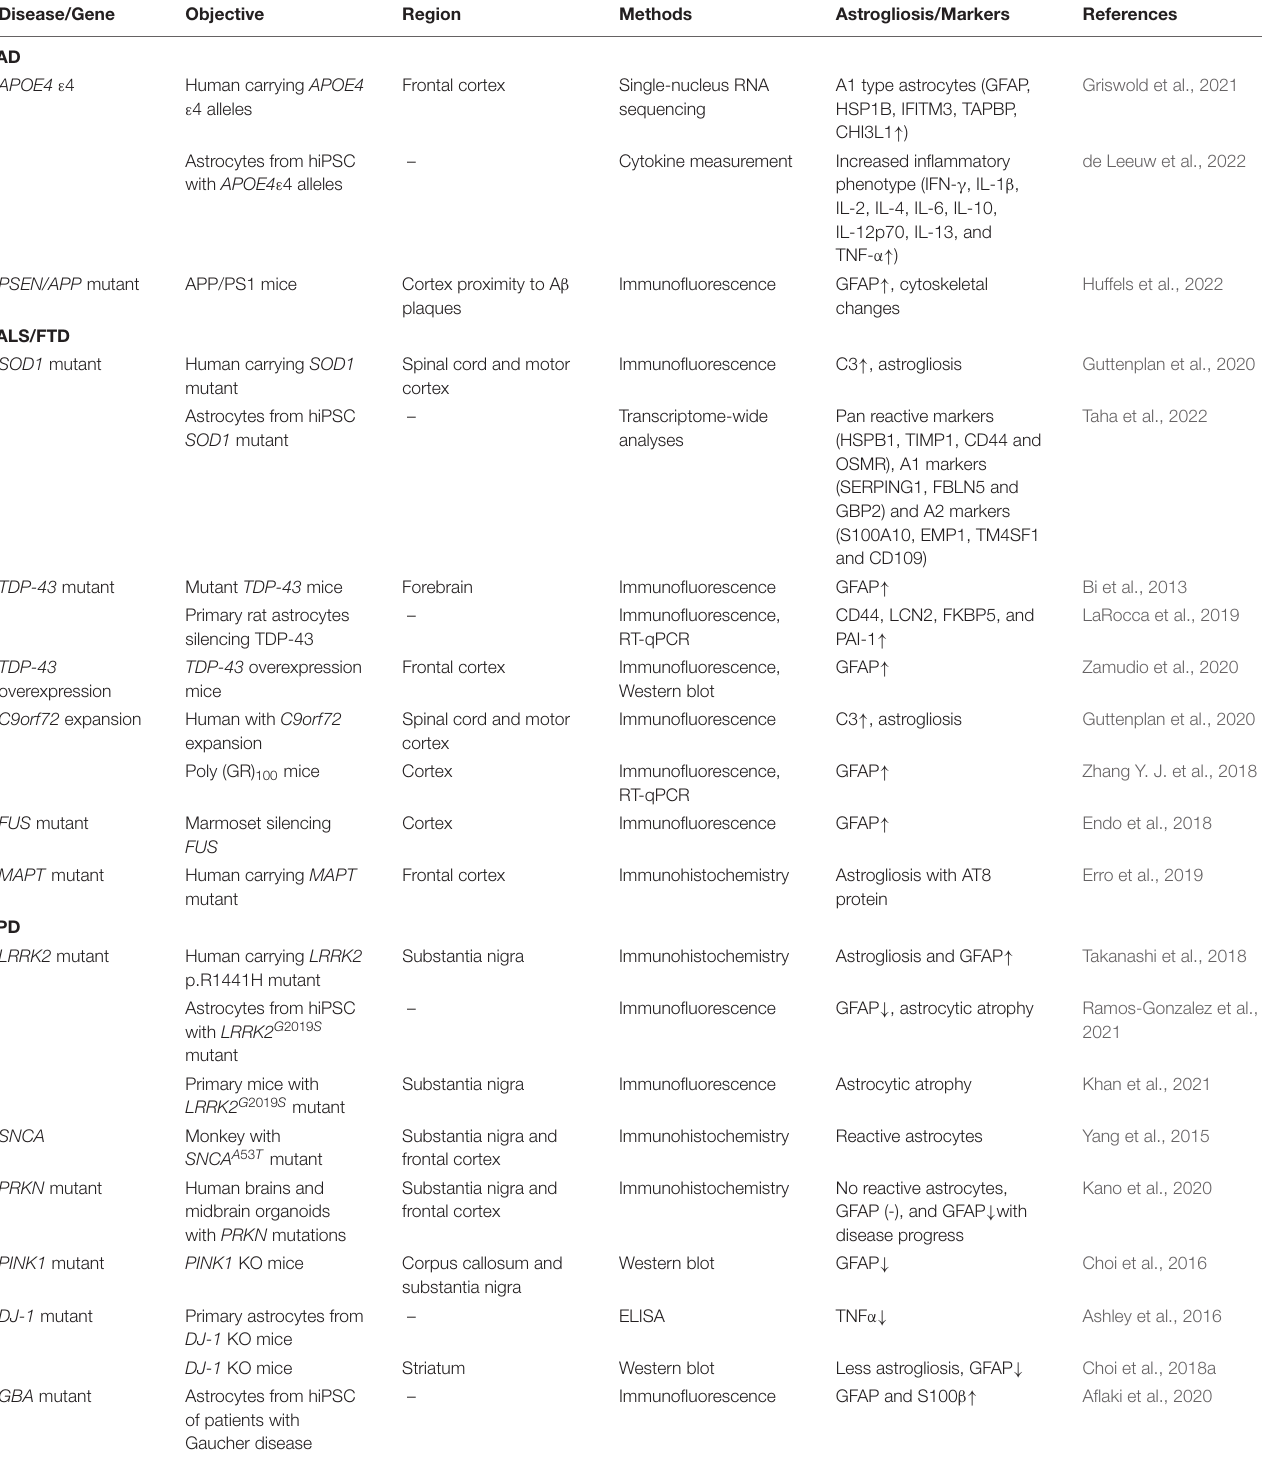
TABLE 1 | Changes of astrocytes with markers in neurodegenerative diseases with gene